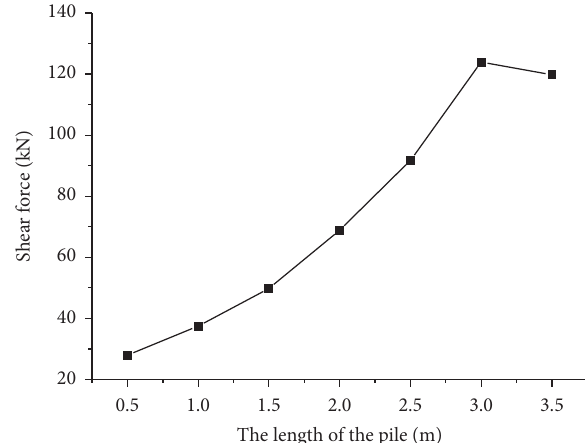
Figure 8: The shear value of pile in the corner of